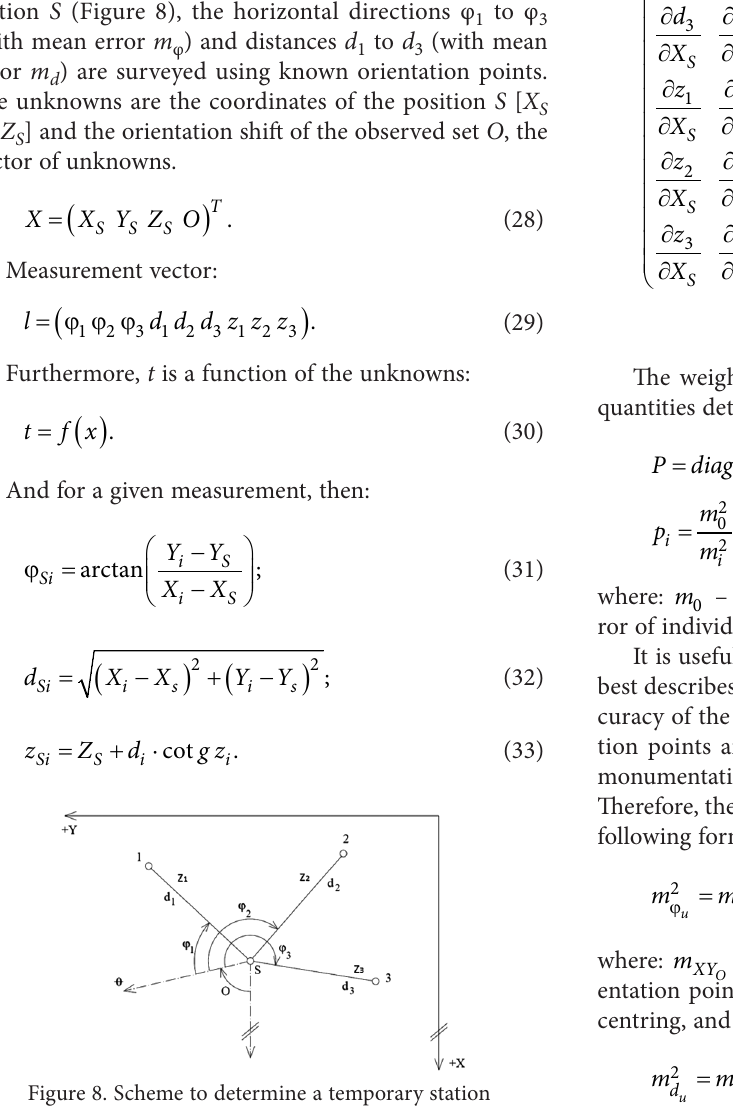
Figure 8. Scheme to determine a temporary